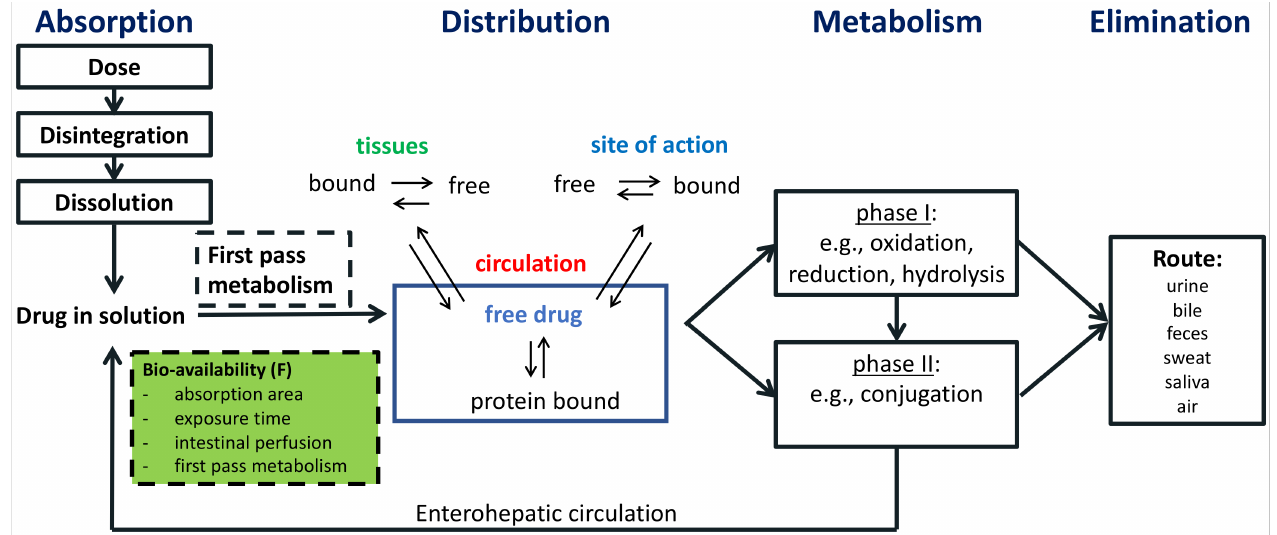
Figure 1. Overview of the pharmacokinetic processes absorption, distribution, metabolism and